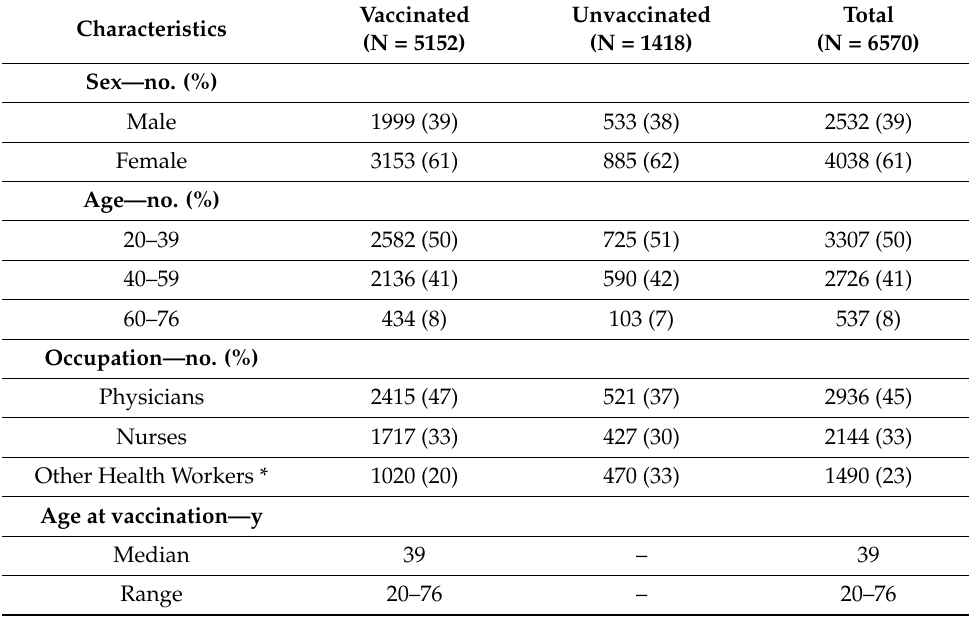
Table 1. Demographic characteristics of health